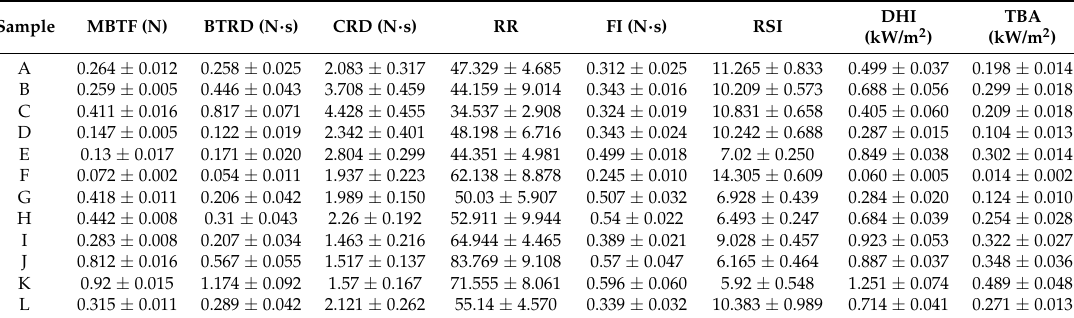
Table 3. Test results by mean values and standard deviation of the evaluation indices.